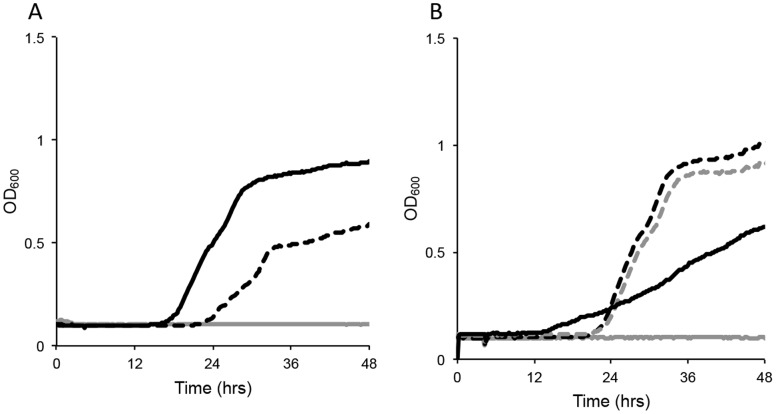
AHL quorum sensing upregulates glyoxylate bypass and enhances growth on acetate.(A) Growth of R88 (black), and an R115 AHL null mutant strain (dashed) of Y. pestis in minimal acetate medium (light grey is medium only control) was monitored in a Bioscreen C microplate reader incubating at 28°C with agitation. (B) Complementation of AHL mutant bacteria with pypeIR (black, dashed) or pyspIR (grey, dashed) restores growth on acetate, whereas control plasmid (black, solid) does not.